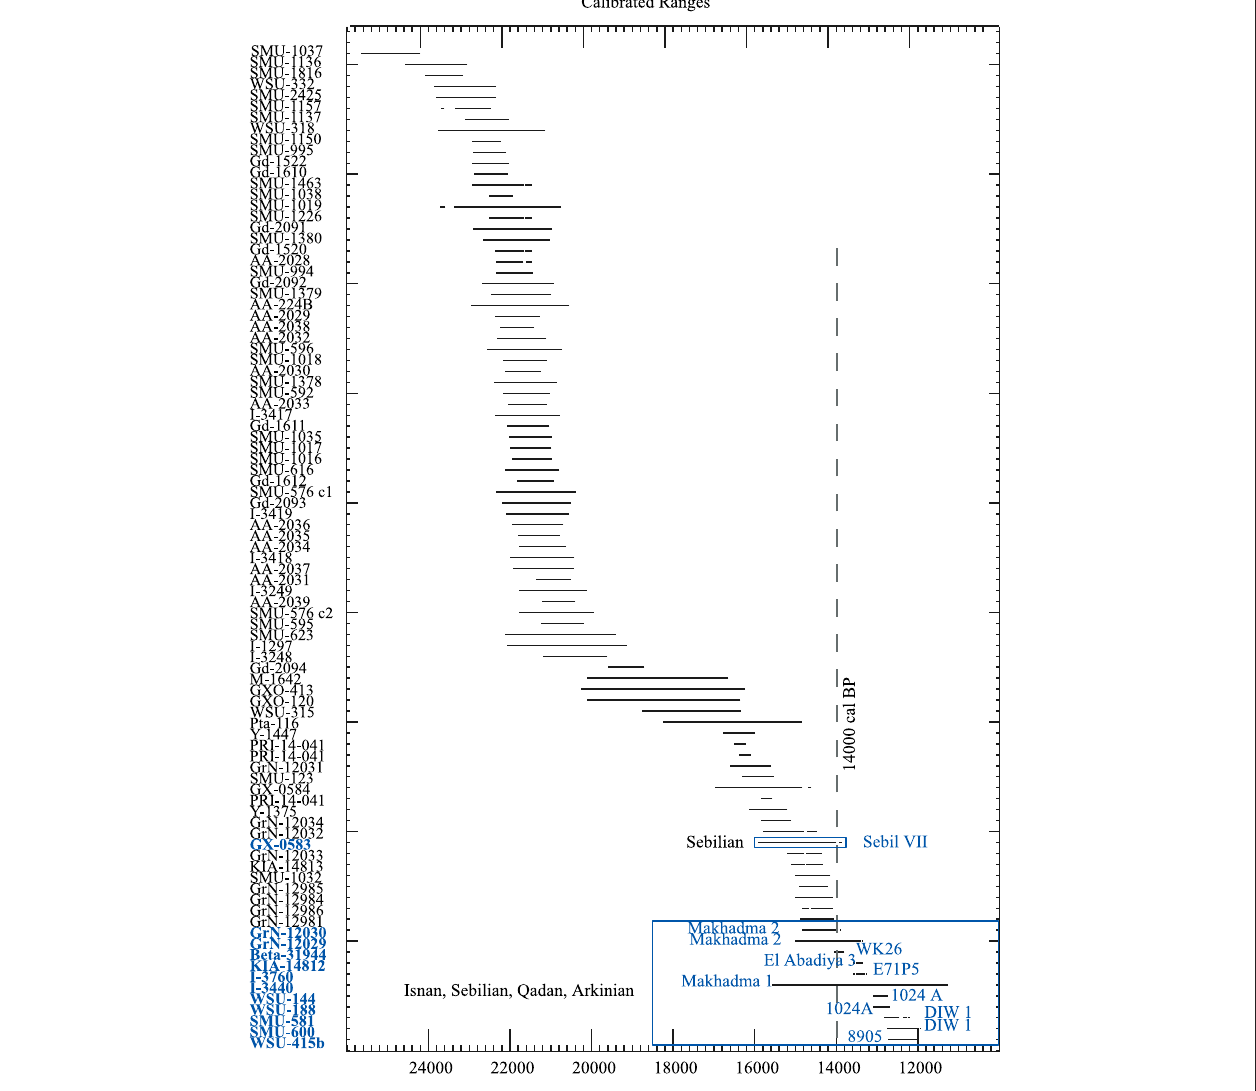
Frontiers in Earth Science |